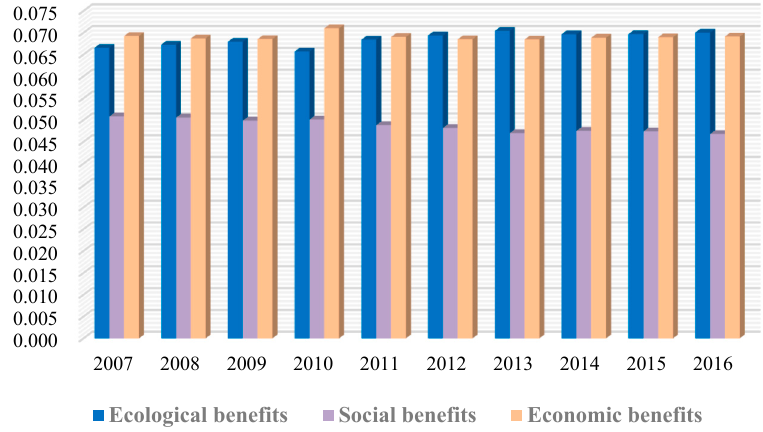
Figure 5. Difference of the obstacle factors’ degree from 2007 to 2016.